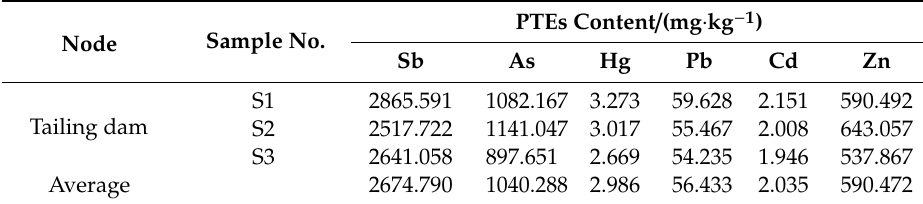
Table 3. PTEs contents in antimony tailings.